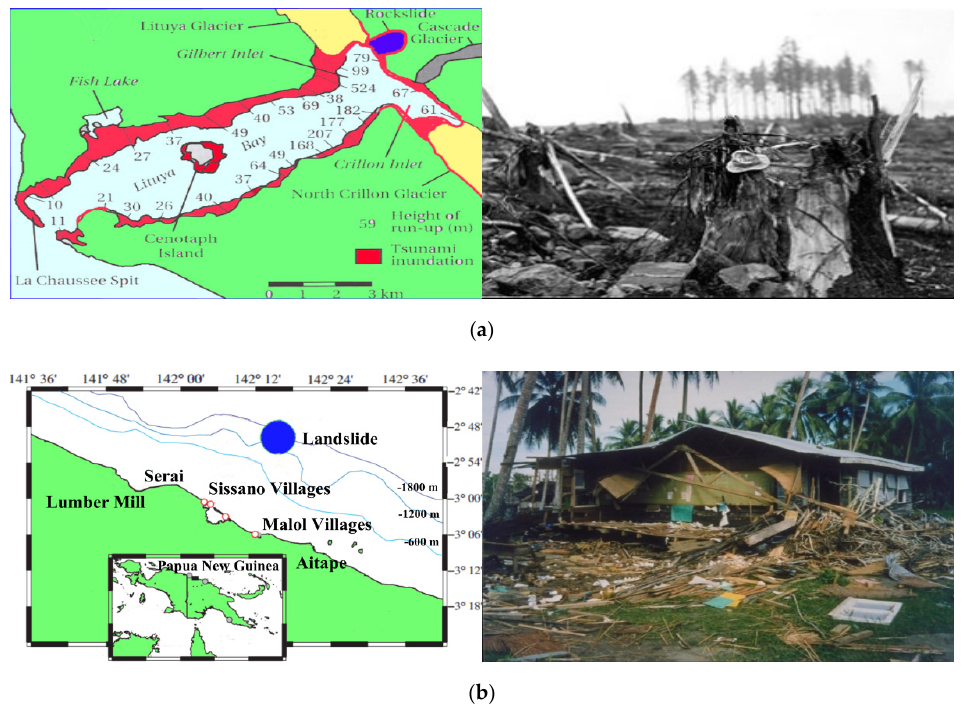
Figure 1. The relevant information and the damage of the Lituya Bay tsunami and the Papua New Guinea tsunami: ( a ) Lituya Bay tsunami; and ( b ) Papua New Guinea tsunami.